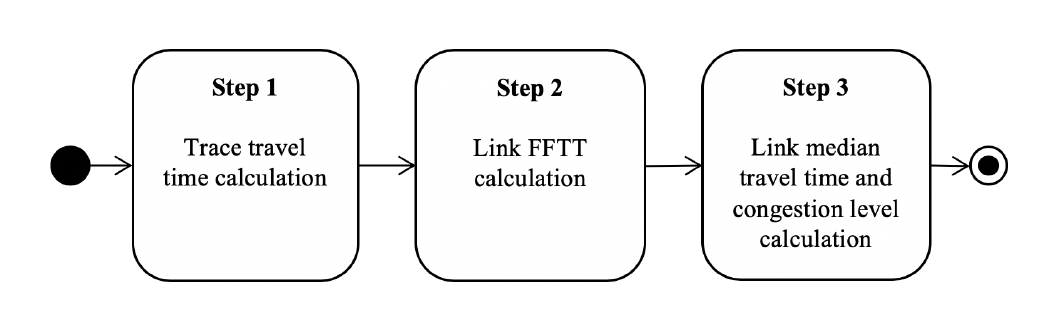
Figure 5. General scaling method. FFTT: free flow travel